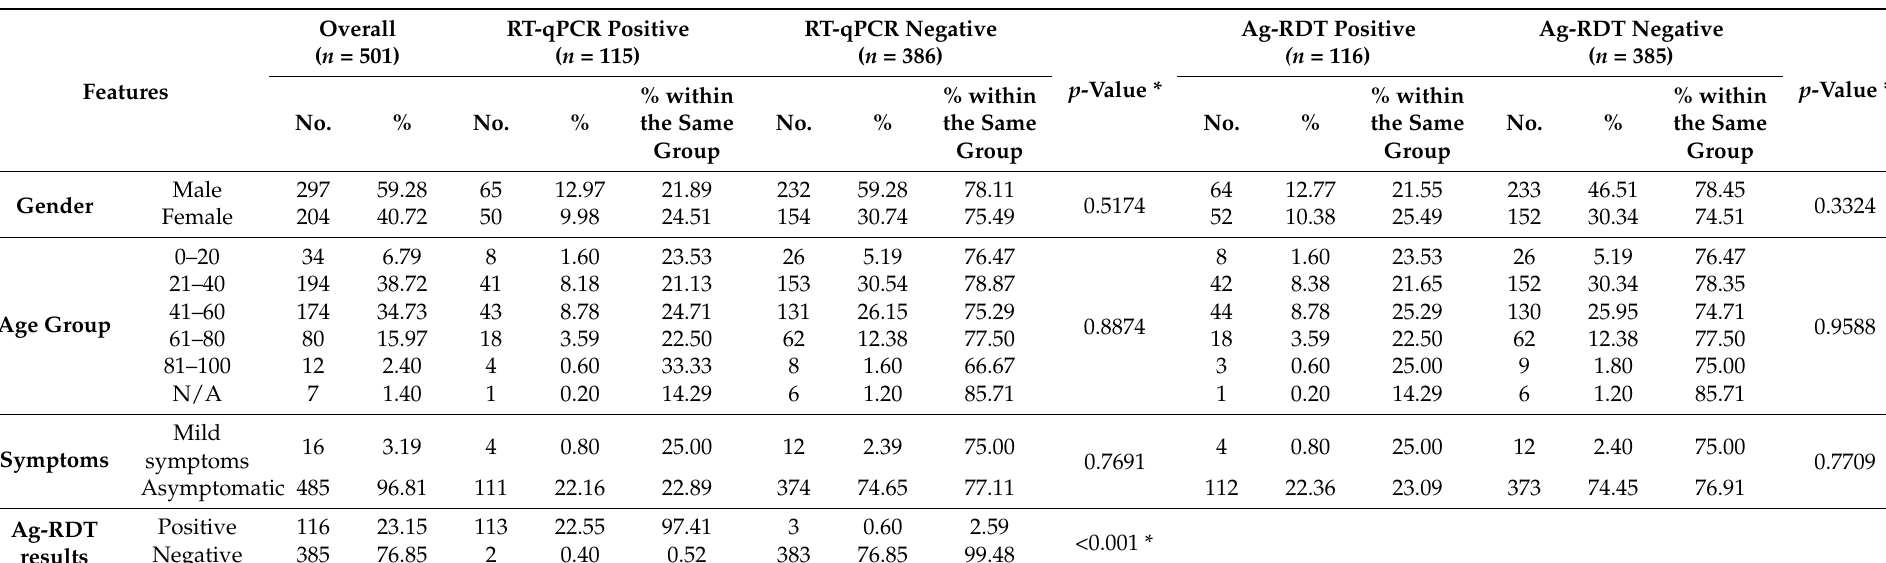
Table 3. Contingency table showing the association of the RT-qPCR results with age, gender, symptoms and the results of the rapid test (two last lines) evaluated by Chi-square/Fisher’s exact test. The p -value from a Fisher’s test is exactly determined and quantifies the significance of the deviation from the hypothesis of non-association (null hypothesis). Statistically significant p <